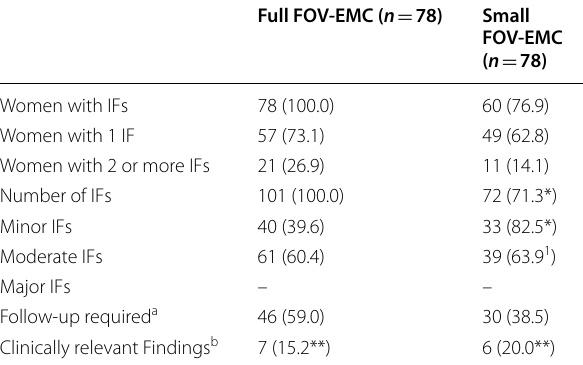
Table 3 Comparison of incidental findings on full field of view (FOV) versus small